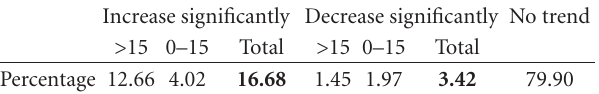
Table 1: The percentage of di ff erent vegetation change trends to the total study area (%).